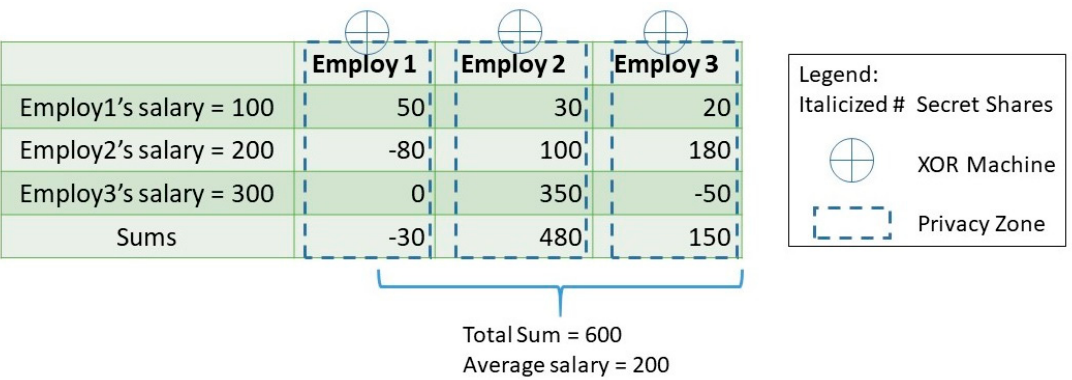
Figure 5. Secure multi-party computation (https://www.inpher.io/ (accessed on 2 December 2020))—overview of the average salary scenario.